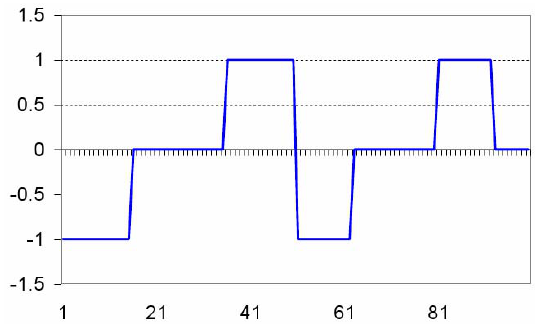
Figure 3. An example for complex structures of IHs. The horizon- tal axis is for the serial numbers of years, while in the vertical axis cumulative e ff ects of IHs are shown. Noise is excluded for the sake of